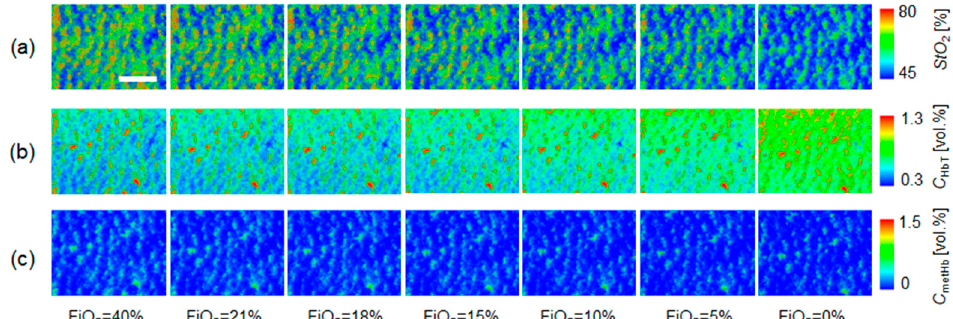
Figure 8. Typical sequential images of ( a ) StO 2 , ( b ) C HbT , and ( c ) C metHb obtained from rat dorsal skin during changes in FiO 2 . A scale bar (white line in the StO 2 image for FiO 2 =40%) indicates 2.0 mm.